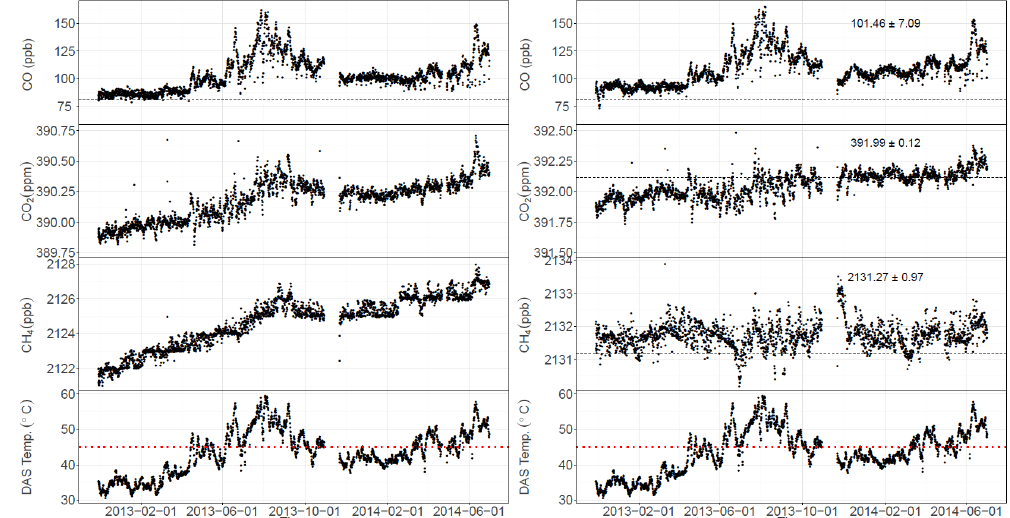
Figure 4. Raw (left) and span-calibrated(right) working gas CO, CO 2 , and CH 4 mixing ratios. The bottom panel in both figures shows the DAS temperature (black) and the analyzer’s cavity temperature records (red) during the measurement period. Note that the CO mixing ratios mirror the DAS temperature record both before and after span calibration of the working gas.